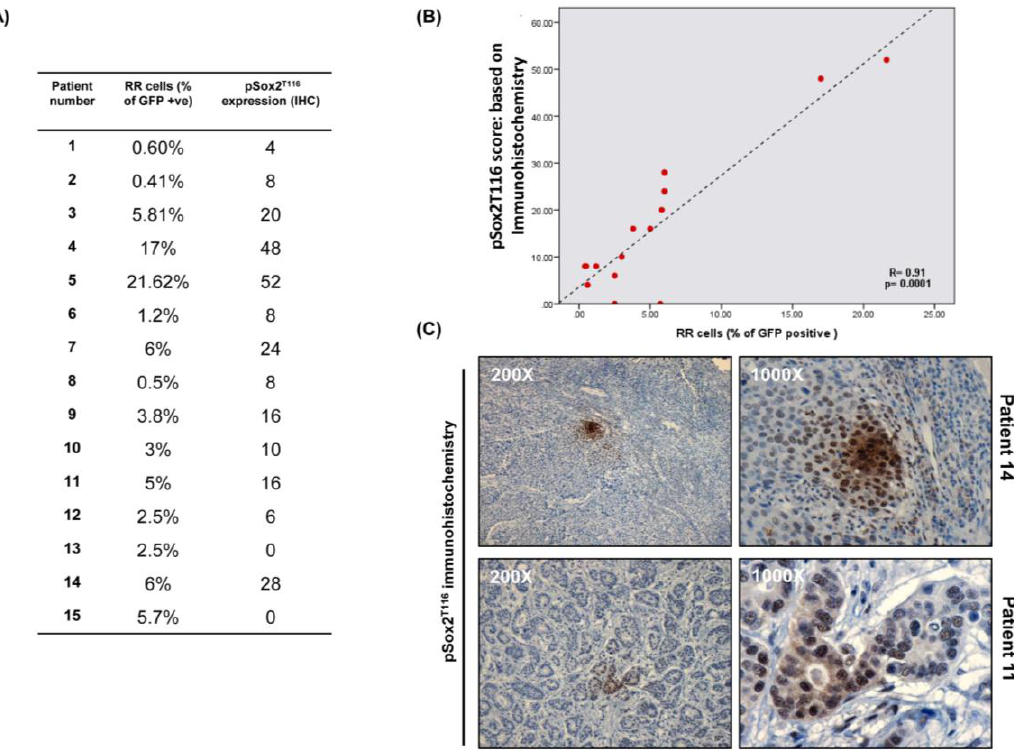
Figure 5. Immunohistochemical studies of pSox2 T116 in primary BC tumors. ( A ) 15 primary BC tumors showing % of RR cells detected by flow analysis and pSox2 T116 expression detected by immunohistochemistry; ( B ) Spearman’s rank correlation was carried out between % of RR cells detected by flow analysis and pSox2 T116 expression detected by immunohistochemistry. Positive correlation was observed between % of RR cells and pSox2 T116 expression (R = 0.91; p = 0.0001); ( C ) Two representative images have been shown here for pSox2 T116 immunohistochemistry.